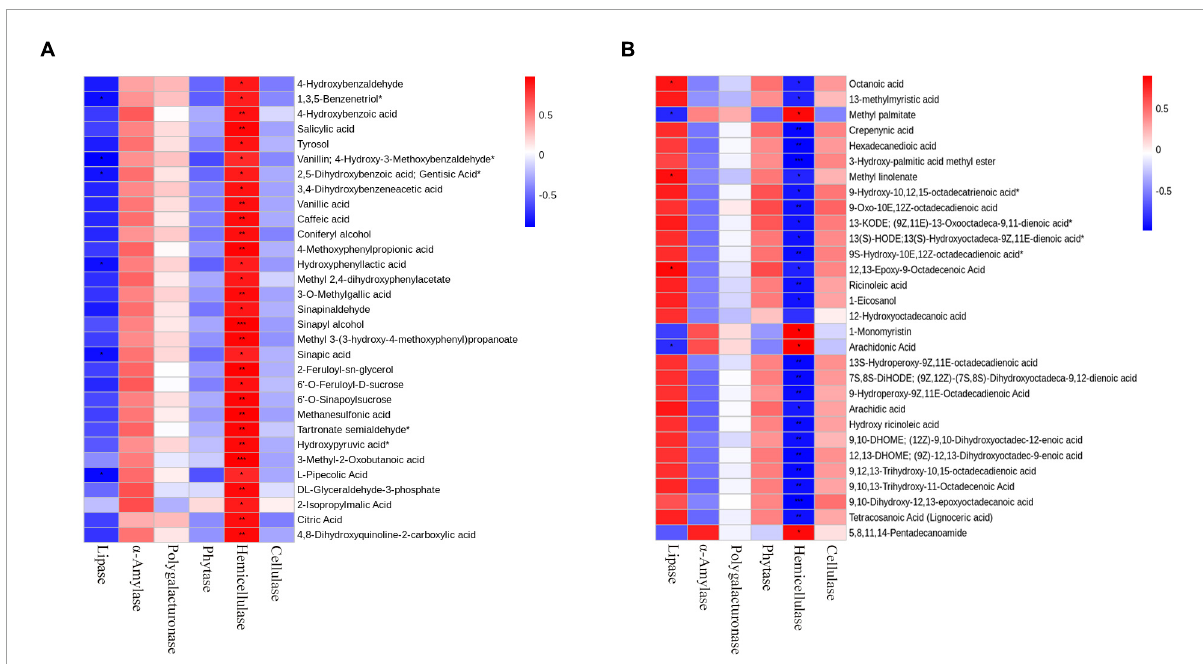
FIGURE7 Correlation diagram of six enzymes with metabolites in fermented rapeseed cake. (A) Correlation diagram of six enzymes with lipids in S3. (B) Correlation diagram of six enzymes with Organic acids in